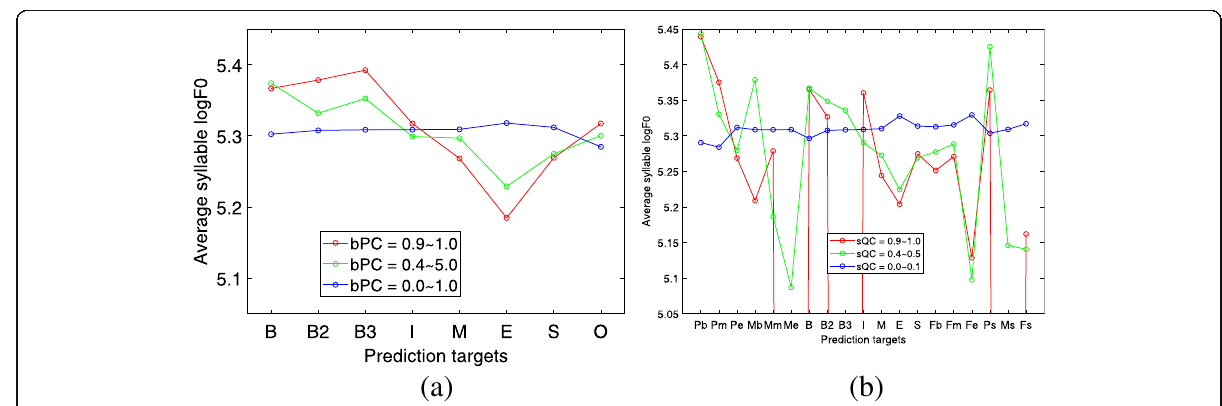
Fig. 9 Average syllable log-F0 corresponding to the prediction targets for a bQC and b sQC in different levels of QC